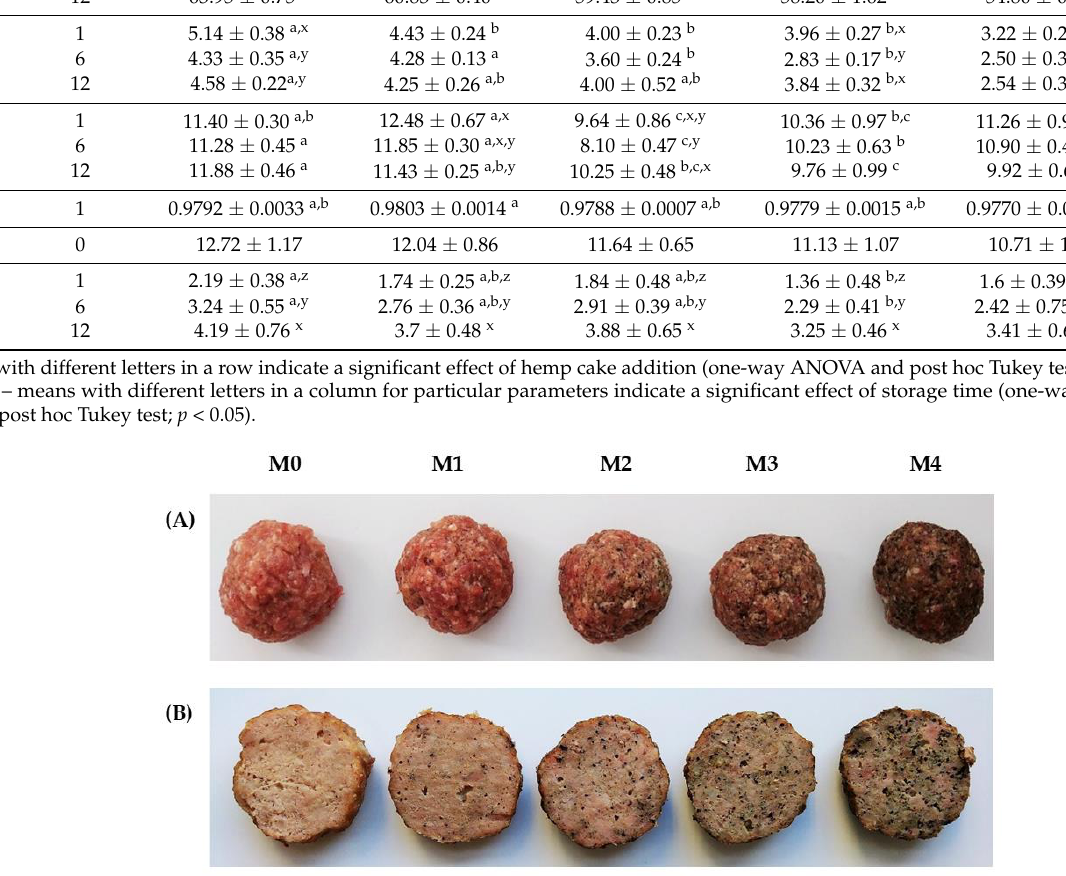
Figure 1. The meatballs before ( A ) and after ( B ) cooking. M0 = control; M1, M2, M3, M4 = meatballs with increasing content of hemp cake, i.e., 0.9%, 2.6%, 4.2% and 7.4%, respectively.